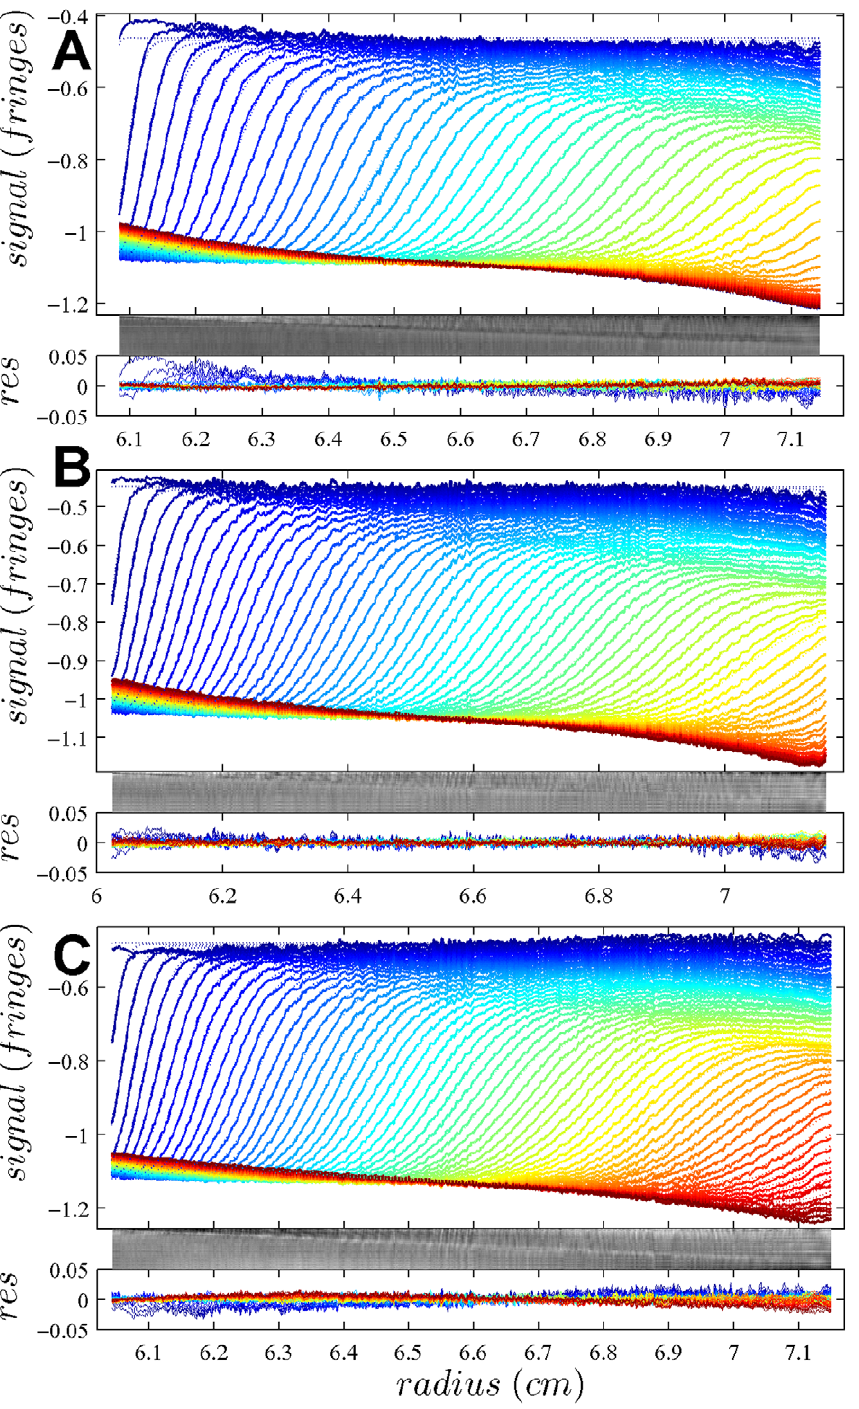
Figure 6. Interference optical data from the same sample as in Figure 4, in the same representation. Rmsd values are 0.00554 fringes (A), 0.00401 fringes (B) and 0.00575 fringes (C).